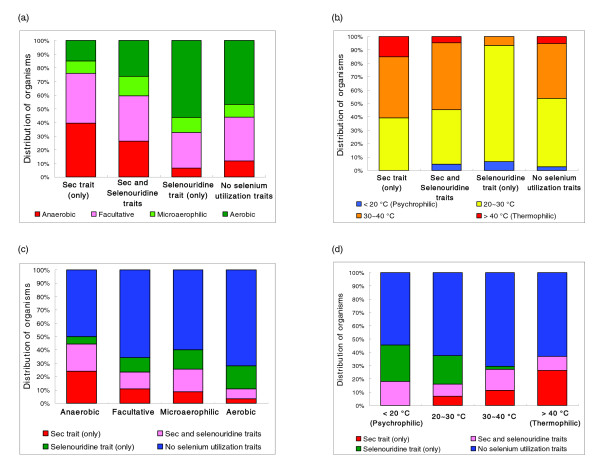
Relationship between selenium utilization traits and environmental factors (oxygen concentration and optimal growth temperature). Organisms were classified into four groups, including those containing the following: the Sec trait only, both Sec and selenouridine traits, selenouridine trait only, and no selenium utilization traits. (a) Distribution of organisms with different selenium utilization traits based on their requirement for oxygen. (b) Distribution of organisms with different selenium utilization traits based on their optimal growth temperature. (c) Distribution of organisms classified according to their oxygen requirement based on their selenium utilization traits. (d) Distribution of organisms classified according to their optimal growth temperature based on their selenium utilization traits.